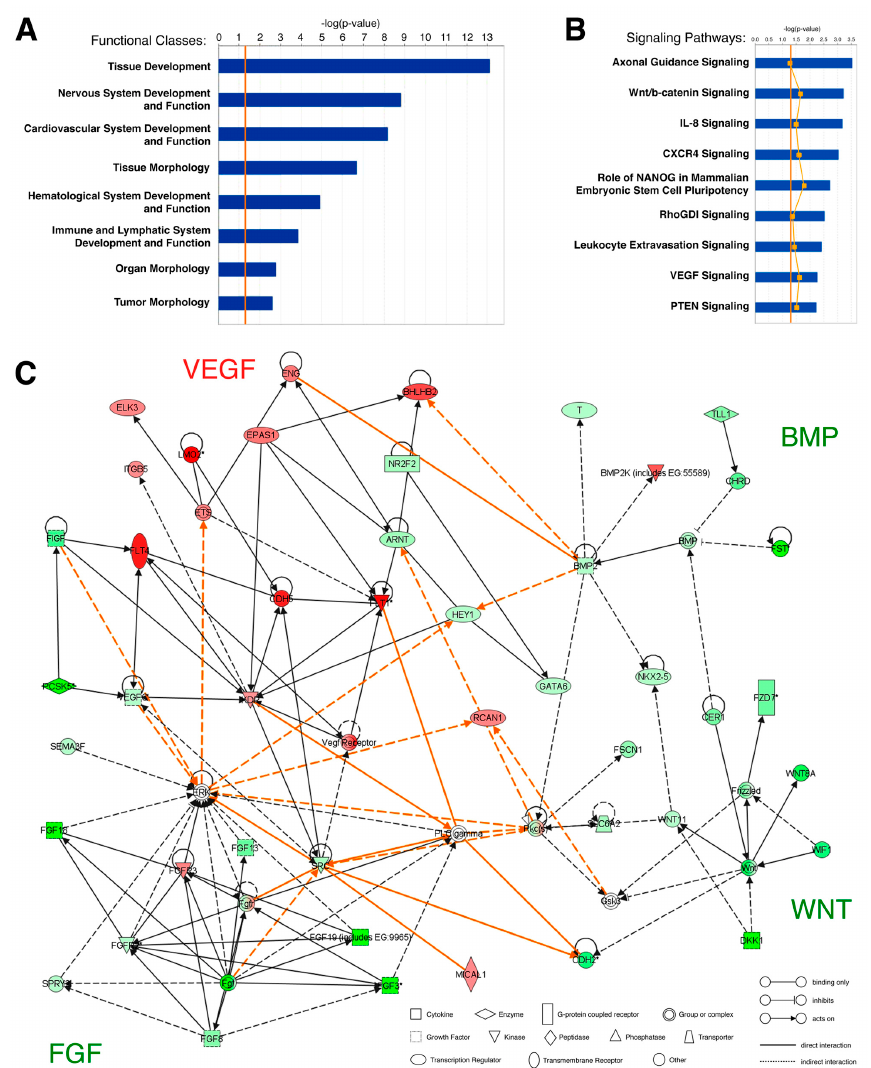
Figure 2. Ingenuity pathway analysis of genes differentially expressed in yolk sac hemangioblasts. ( A ) Top classes of biological functions and ( B ) canonical signaling pathways most significantly represented in the Hb-eGFP+ microarray dataset (Ingenuity Pathways Analysis (IPA) library; Ingenuity Systems, www.ingenuity.com). Genes that met the fold change cutoff of 1.2 were considered for the analysis. Bars indicate the minus log of the p -value of each functional class/canonical pathway. The threshold line (orange) corresponds to a p -value of 0.05. The yellow line in ( B ) represents the ratio between the number of genes from the dataset in a given pathway that meet the cutoff criteria and the total number of genes of that pathway; ( C ) Network diagram representing the molecular relationships between genes differentially expressed in hemangioblasts. This graphical representation generated by IPA includes gene products of four functional classes: Cellular Development, Cardiovascular System Development and Function, Organismal Development, Organ Development and Cell Signaling. Gene products are represented as nodes (shapes) and the biological relationship between two nodes is represented as an edge (line). Orange lines represent interactions between gene products from different canonical pathways. All edges are supported by at least one reference from the literature, from a textbook, or from canonical information stored in the Ingenuity Pathways Knowledge Base. The intensity of the node color indicates the degree of upregulation (red) or downregulation (green). Nodes are displayed using various shapes that represent the functional class of the gene product, while edges are displayed with various labels that describe the nature of the biological relationship between the nodes (see legend in the